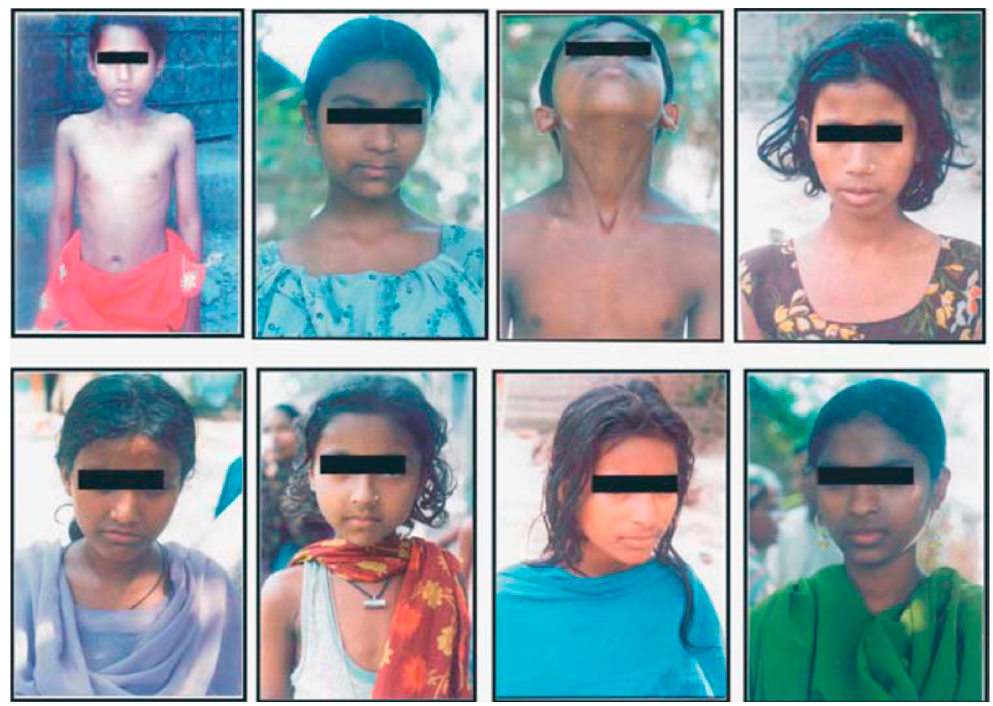
Figure 5. A group of children suffering from arsenical skin lesions in Bangladesh.